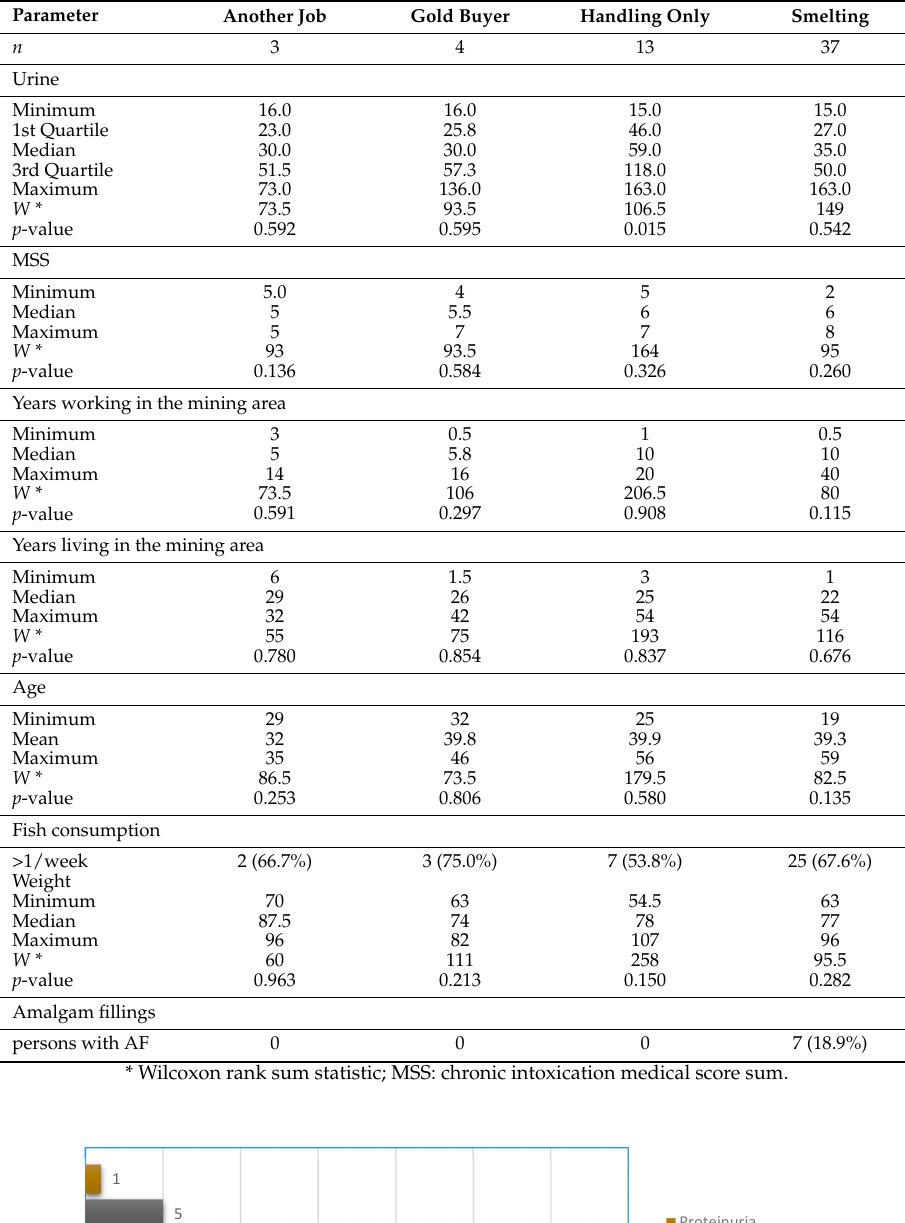
Table 3. Stratification of characteristics by job category.